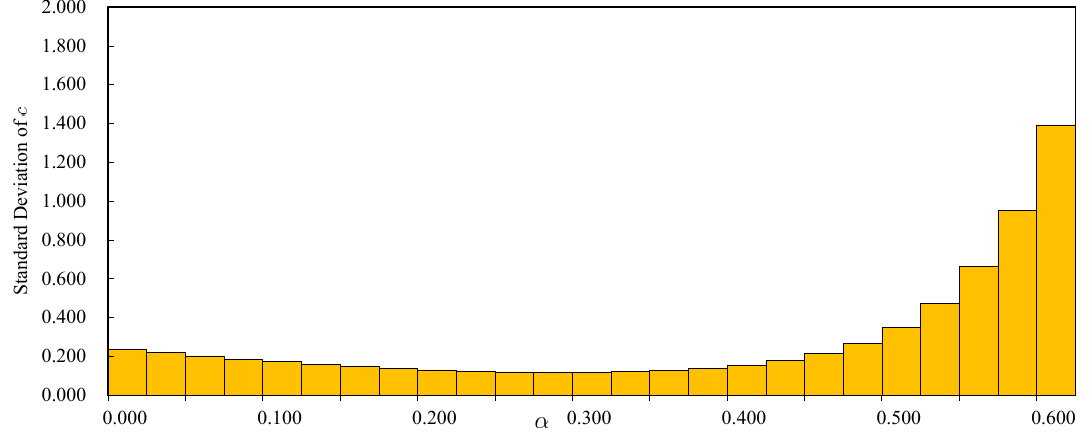
Figure 5 . The standard deviation of c = m tower / | Λ | α for each α in the case of isotropic SUSY vacua. The range of α shown in the figure is set as [0 . 000 , 0 . 600] and the increments are 0.025. In this figure, α = 0 . 275 gives the minimum value 1 . 09 × 10 − 2 .